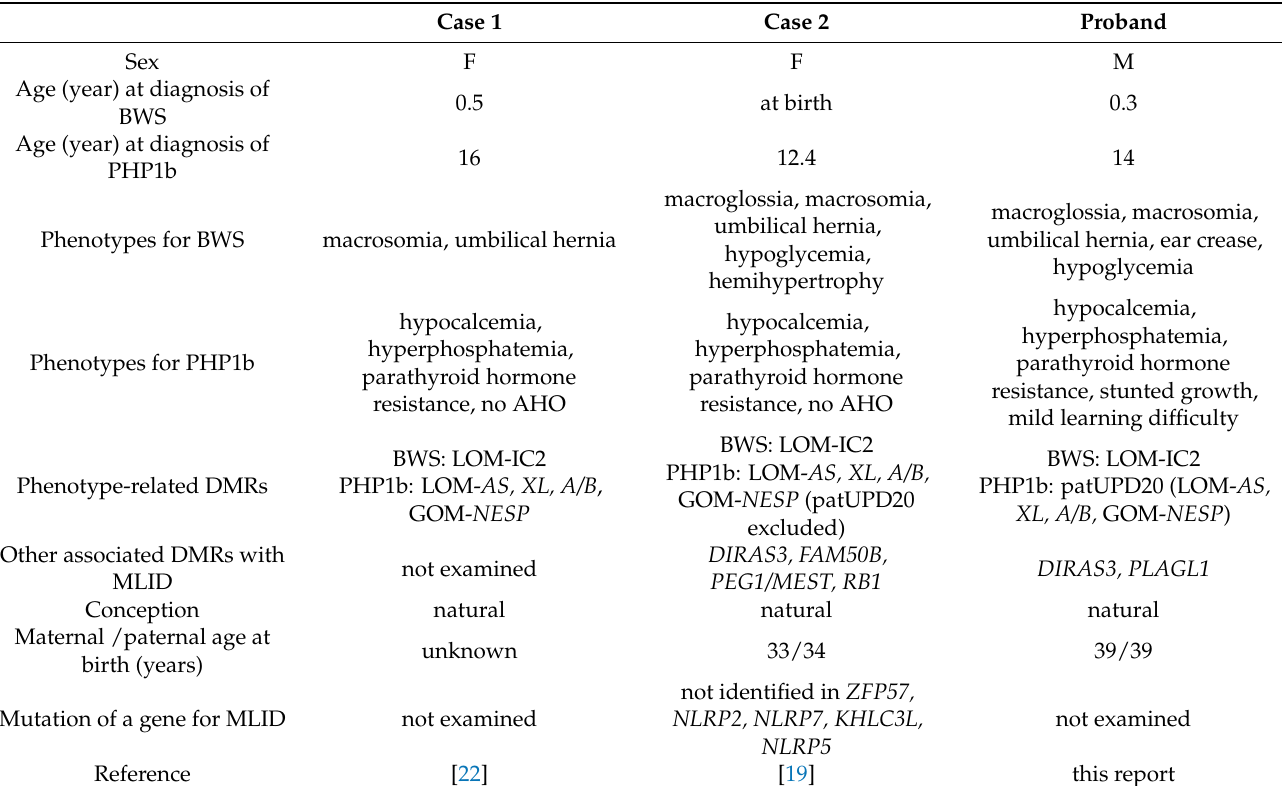
Table 2. Summary of the reported patients with coexistence of BWS and